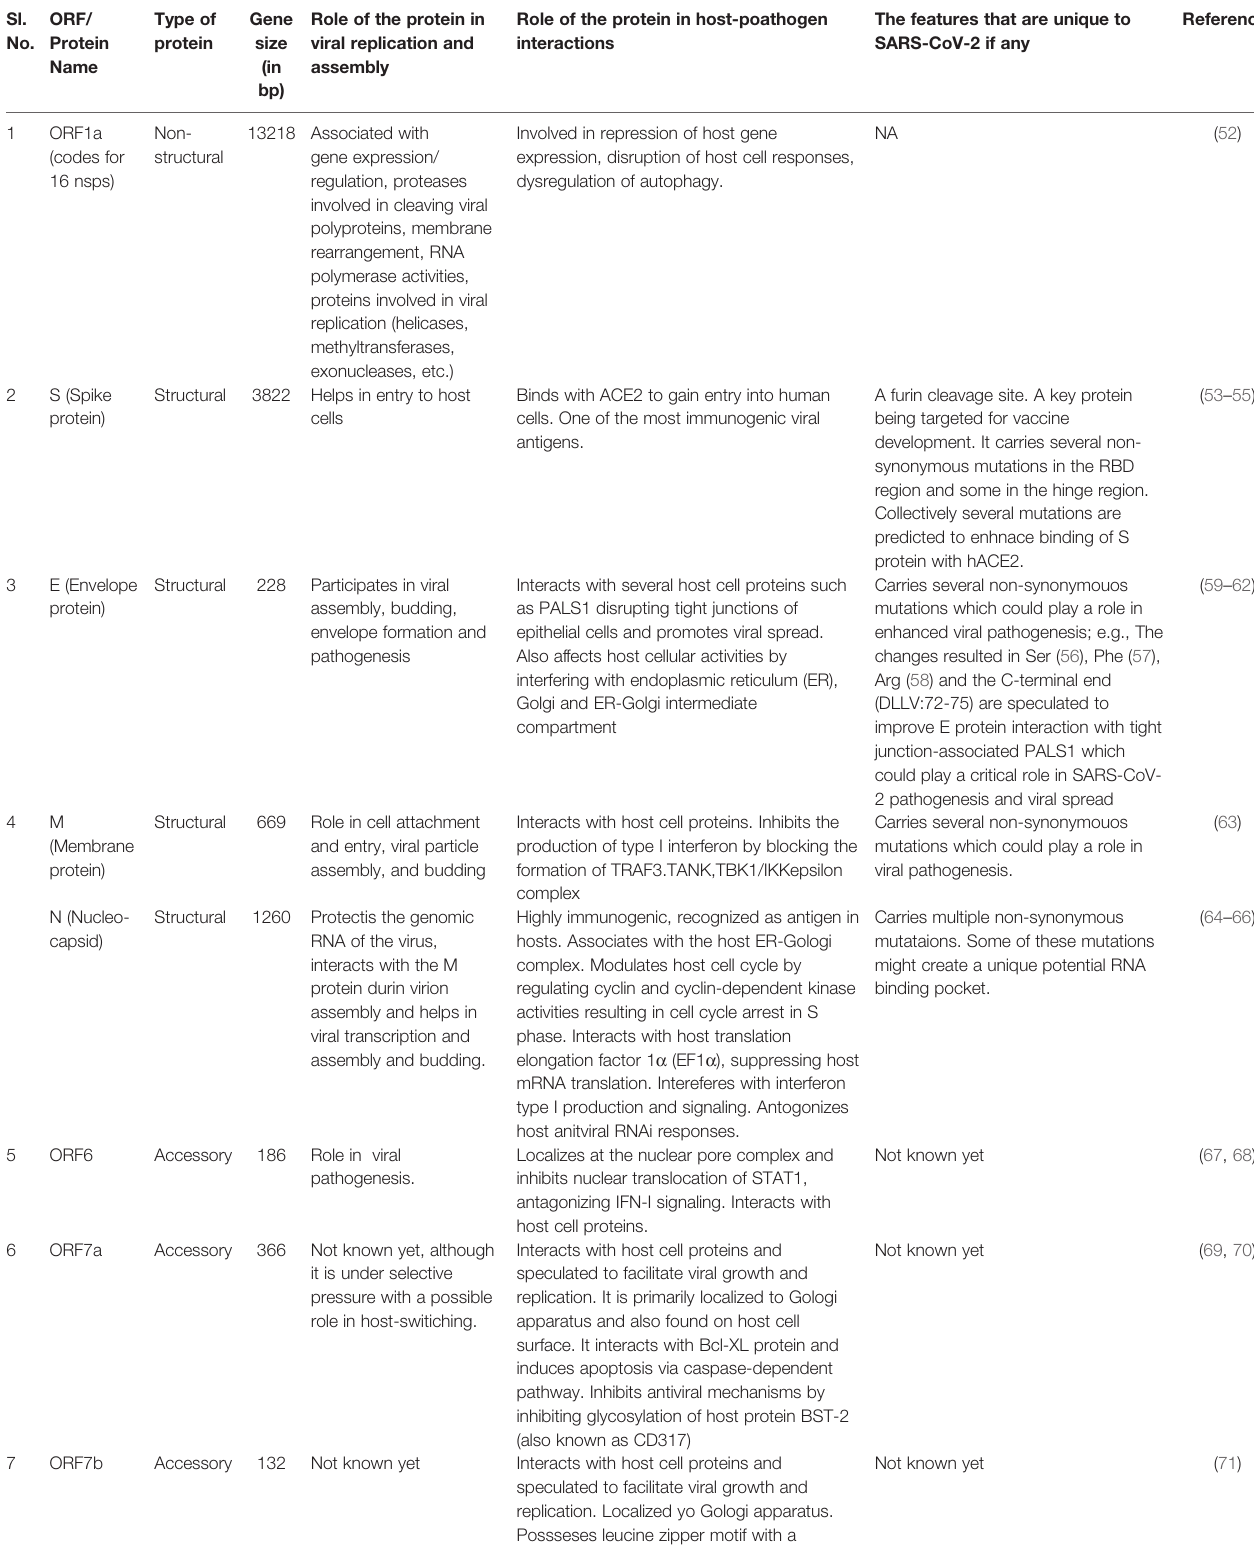
TABLE 1 | Genes encoded by SARS-CoV-2 and their known or predicted functions. Sl. ORF/ No.